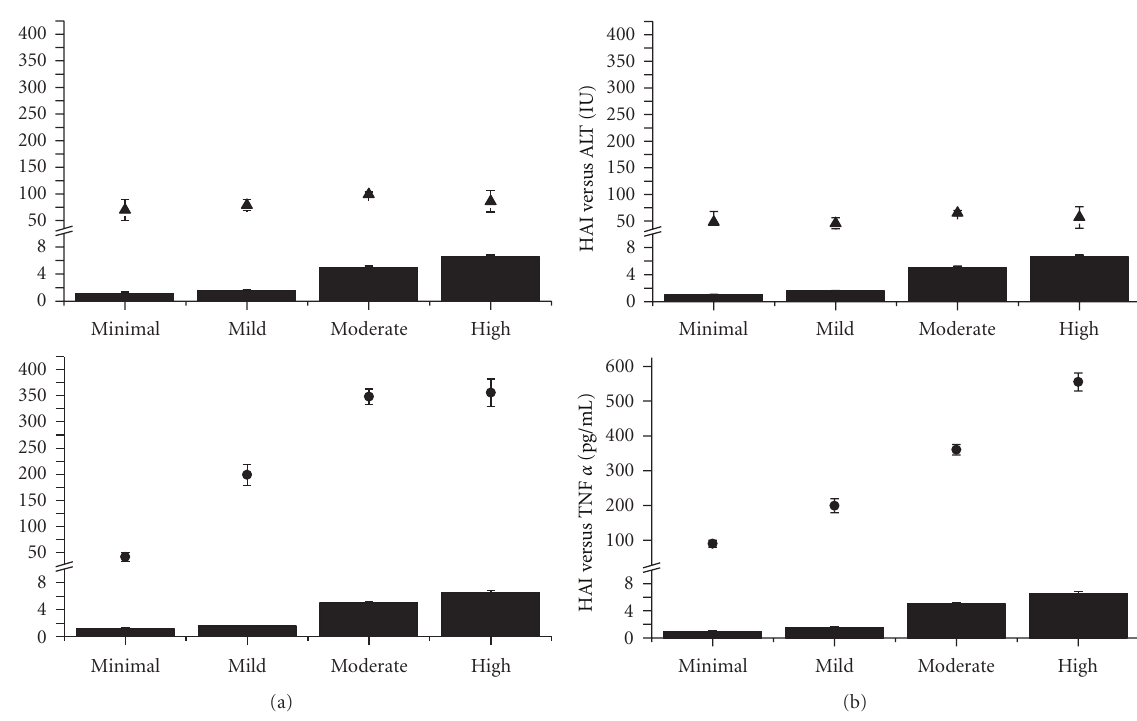
Figure 1: (a) Correlation between the ALT ± SD measured in U/L (upper panel) (triangles) and HAI (columns: minimal, mild, moderate, and high inflammation by histology) in HCV. The lower panel presents the correlation between TNF- α ± SD ((pg/mL) rhomboid) and histological activity index (HAI-columns) in the same set of patients. (b) Correlation between the ALT (U/L ± SD (triangles)) and HAI (solid black columns) is presented in the upper panel graph. TNF- α ((pg/mL ± SD) rhomboid) is correlated in the lower panel with HAI (solid black columns HAI-0, mild, moderate, high) in patients with ALD.